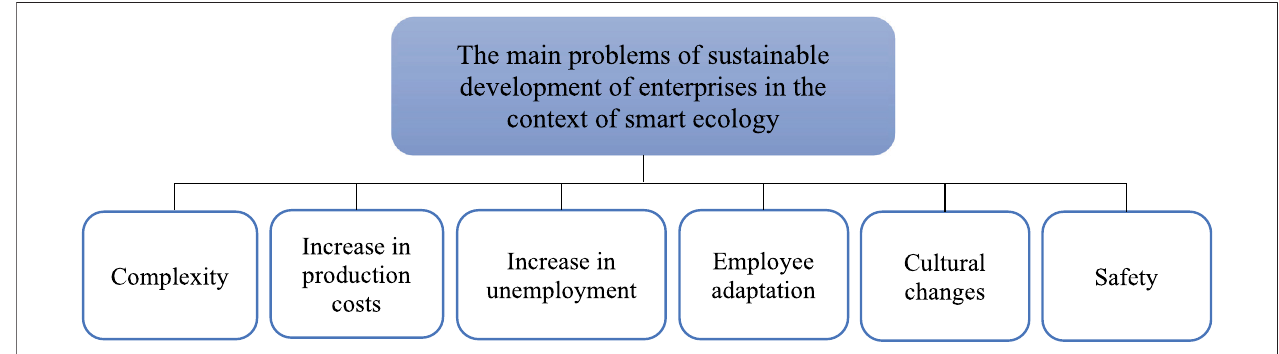
FIGURE 1 | The main problems of sustainable development of the enterprise in the conditions of smart ecology (Open School of Business, 2016).